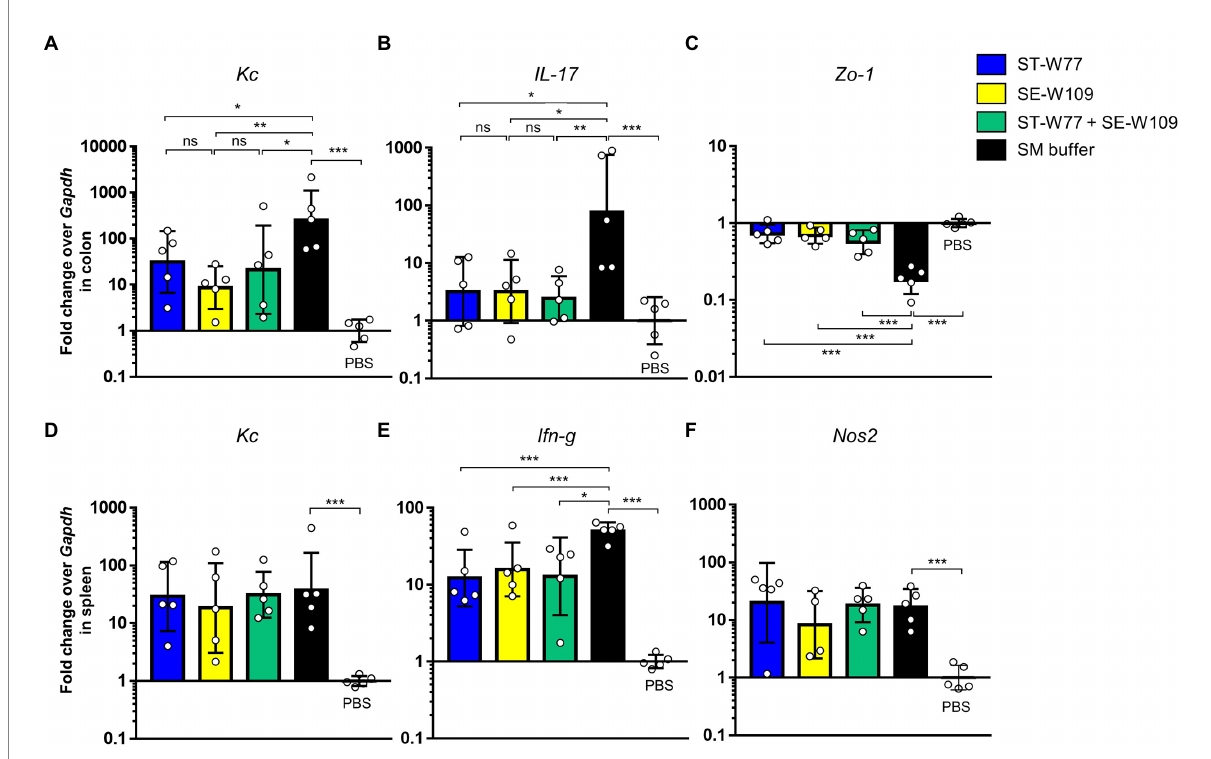
FIGURE 6 A reduction of proinflammatory makers in S. Tm infected mice orally treated with phages ST-W77 and SE-W109. Mouse tissues (colon and spleen) were collected for mRNA extraction and qPCR analysis. Colonic proinflammatory genes Kc (A) , IL-17 (B) , and tight junction Zo-1 (C) gene expressions were investigated. Expression of splenic proinflammatory genes Kc (D) , Ifn-g (E) , and Nos2 (F) was shown. Bars represent the geometric mean; error bars indicate geometric standard deviation. *, **, *** indicated p < 0.05, 0.01 and 0.001, respectively. ns, non-statistically significant difference; PBS, phosphate-buffered